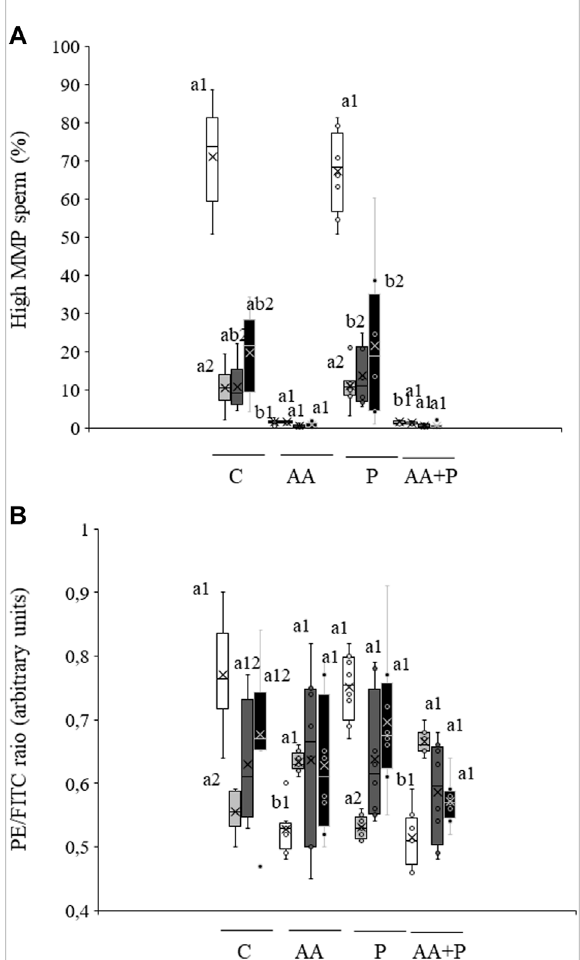
FIGURE 2 Box-and-whiskerplotoftheeffectsofantimycinAandPKCion mitochondrial membrane potential. Sperm were subject to separate redLEDlightirradiationpatternsinthepresenceof1 µMantimycinA, 100 nM PKCi orboth together, and parameters related to MMP wereanalyzedasdescribedinMaterialsandMethodssection.Sperm were not irradiated (white boxes) or irradiated with red LED light for 1 min (light grey boxes), 5 min (dark grey boxes) or 10 min (black boxes) in the absence (C) or presence of 1 µM antimycin A (AA), 100 nMPKCi(P)or1 µMantimycinAand100 nMPKCitogether(AA+ P). (A) percentages of sperm with high MMP. (B) Mean values of the JC-1 agg /JC-1 mon ratiointhespermpopulationwithhighMMP.Figure shows means ± S.E.M. for eight biological replicates involving eight independent samples. Asterisks inside boxes indicate means, whereas lines inside represent medians. Different superscript numbers indicate signi fi cant ( p < 0.05) differences between samples pre-incubatedwiththesameinhibitor(i.e.,Control,antimycinA,PKCi or antimycin A + PKCi) but subject to distinct irradiation patterns (i.e.,0, 1, 5 or 10 min). Different superscript letters indicate signi fi cant ( p < 0.05) differences between samples incubated with separate inhibitors (Control, antimycin A, PKCi, or antimycin A + PKCi) and irradiated with the same